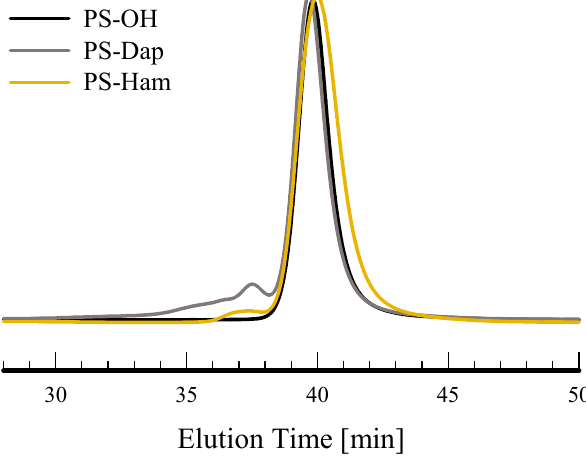
Figure 10. SEC traces of the samples PS ‐ OH, PS ‐ Dap, and PS ‐ Ham.